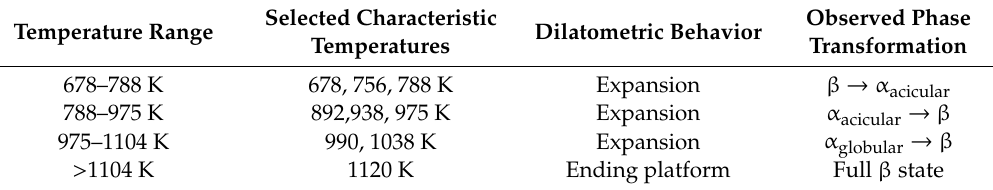
Table 3. Dilatometric behaviors and phase transformations during 1 K / min heating.